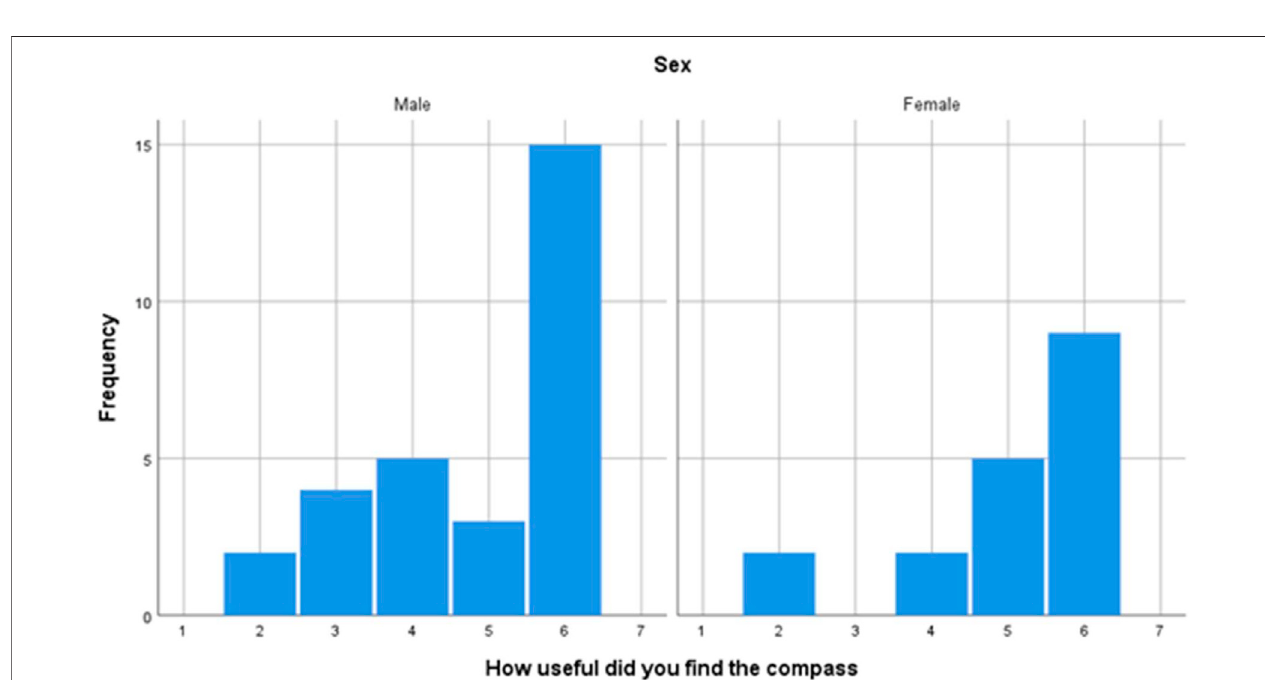
FIGURE 12 | Questionnaire participants results for how useful users found the compass in locating hazards.